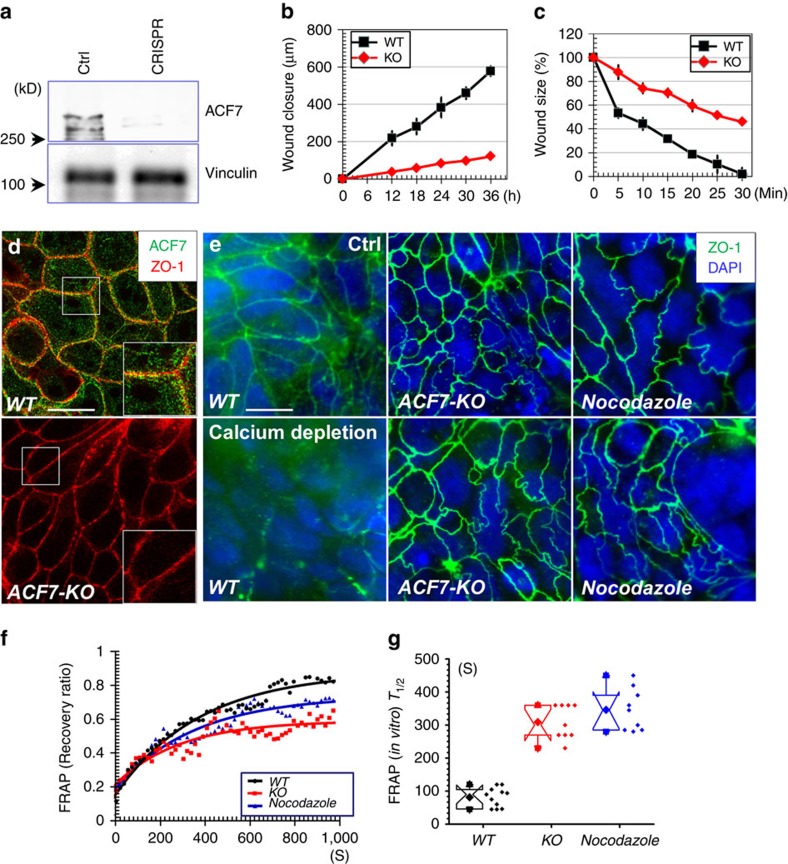
ACF7 regulates motility and tight junction dynamics in colorectal epithelial cells.(a) Western blot analysis verified CRISPR-mediated deletion of ACF7 in Caco-2 cells. Blot of vinculin servers as a loading control. (b) Confluent monolayer of Caco-2 cells was subjected to in vitro scratch-wound assay. Quantification of the kinetics of wound closure shows slower movement of ACF7-deficient cells. Error bar represents standard deviation (s.d.). Sample size n=3 (three independent tests). (c) Oligocellular wounds were introduced to monolayer of WT or ACF7-null Caco-2 cells. Quantification of the kinetics of the wound closure shows impaired wound healing upon loss of ACF7. Error bar represents s.d. Sample size n=3 (three independent tests). (d) WT or ACF7 KO caco-2 cells were subjected to immunofluorescence staining with different antibodies as indicated. Boxed areas are magnified as insets. Scale bar, 50 μm. (e) WT or ACF7 KO cells or WT cells treated with nocodazole were stained for tight junctions with antibody against ZO-1, before or after calcium depletion. Cell nuclei are counter-stained with DAPI. Scale bar, 50 μm. (f) In vitro FRAP analysis of mRFP-ZO1 in WT cells, nocodazole-treated WT cells and ACF7-deficient Caco-2 cells. Experiments repeated for more than three times. (g) Box and whisker plotting of T1/2 for FRAP analysis in vitro. The box and whisker plot indicates the mean (solid diamond within the box), 25th percentile (bottom line of the box), median (middle line of the box), 75th percentile (top line of the box), 5th and 95th percentile (whiskers), first and 99th percentile (solid triangles) and minimum and maximum measurements (solid squares). Deletion of ACF7 and nocodazole treatment significantly increase T1/2 (P<0.01, Student’s t-test). Sample size n>9 (three independent tests, and three technical replicates each).